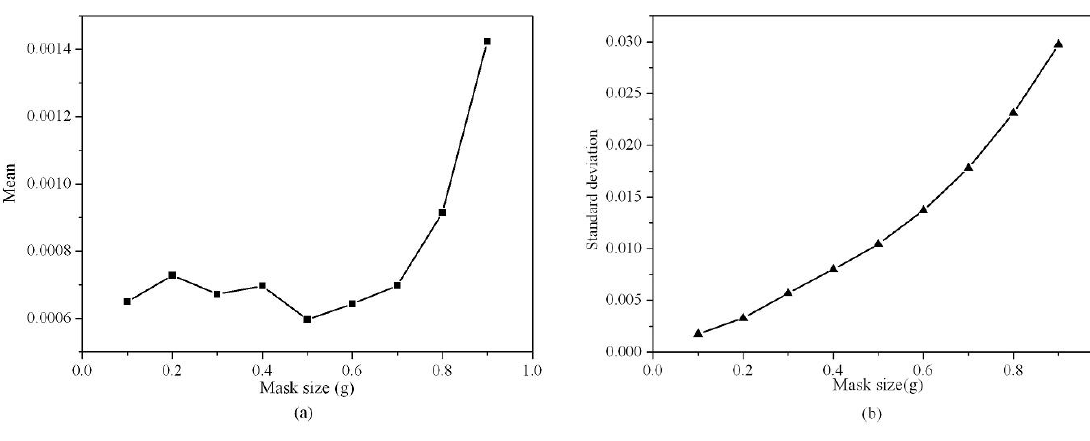
in reference area by using xx